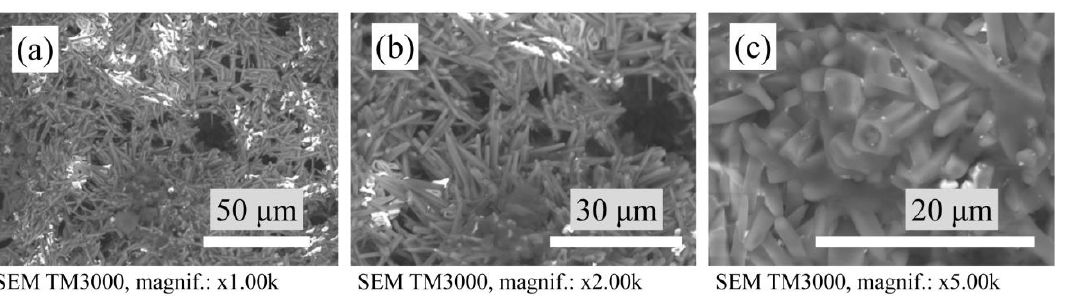
Figure 5. SEM micrographs of the microstructure of sintered samples: ( a ) with YSZ:WO 3 (1:1), ( b ) with MSZ:WO 3 (1:1) and ( c ) with YSZ:WO 3 (1:2).